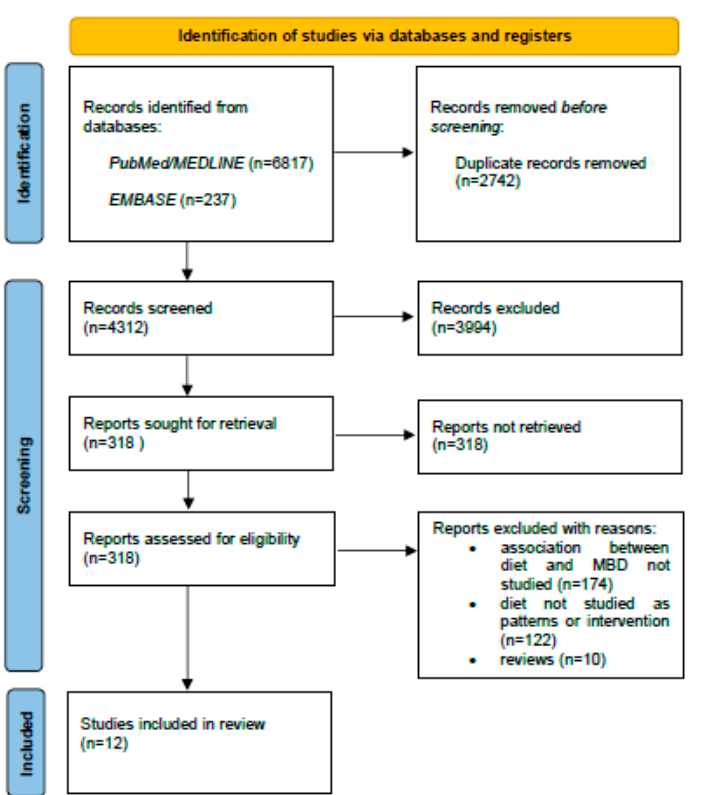
Figure 1. Flow diagram for the literature search and selection of articles on the association between a priori and a posteriori dietary patterns and dietary interventions and mammographic breast density (MBD).